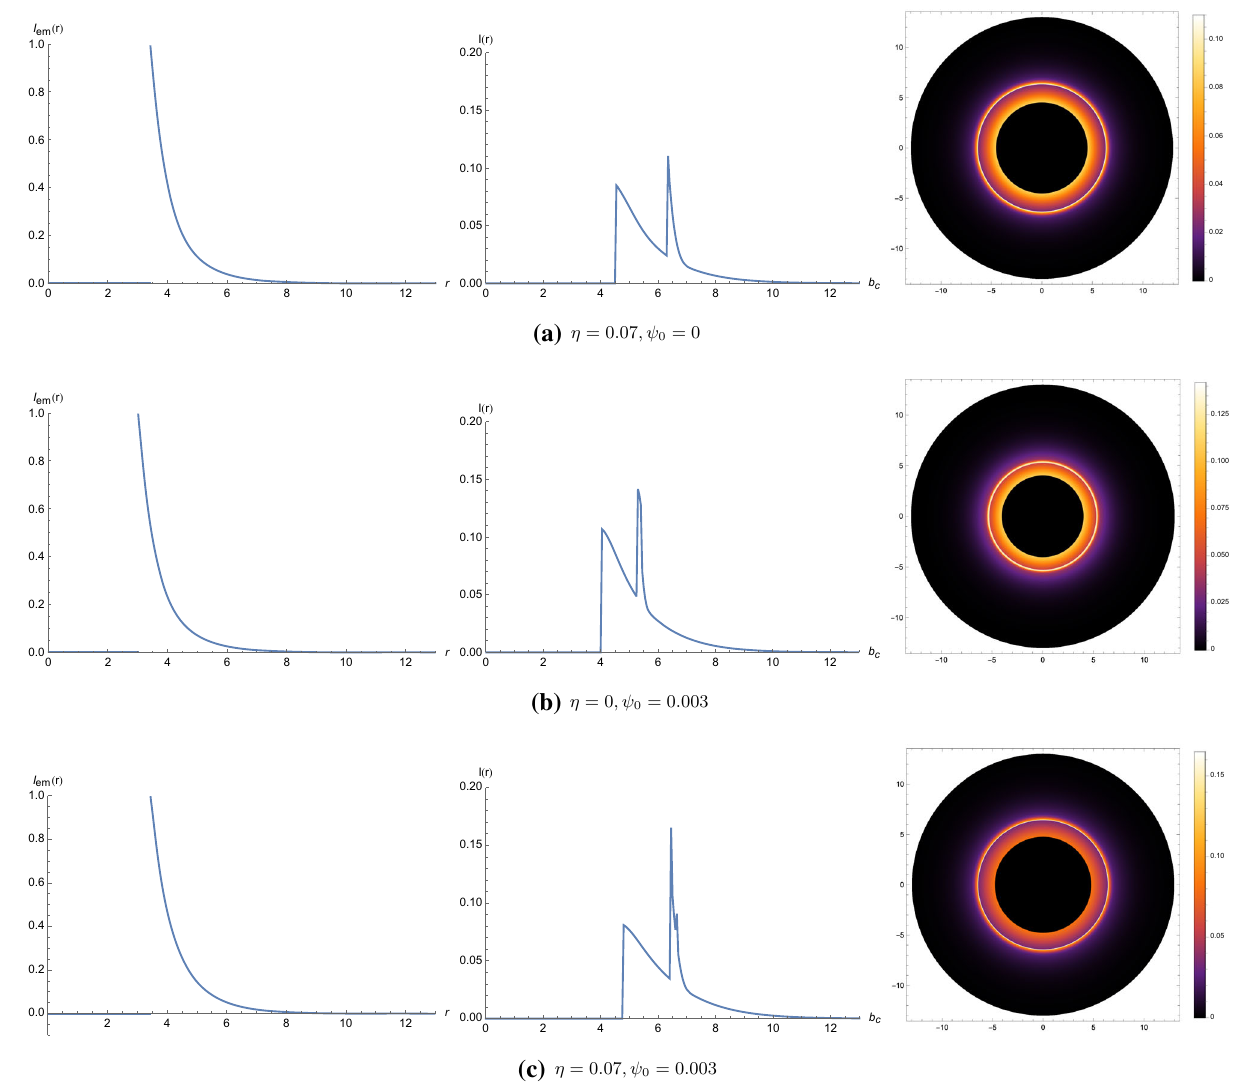
Fig. 6 Observational appearances of the thin disk for the function I (cid:5)(cid:5) tively. Similarly, η and ψ 0 all decreased observed intensities of direct emission and rings as before. The right column of Fig. 7 shows the corresponding shadows and rings for differ- ent value of η and ψ 0